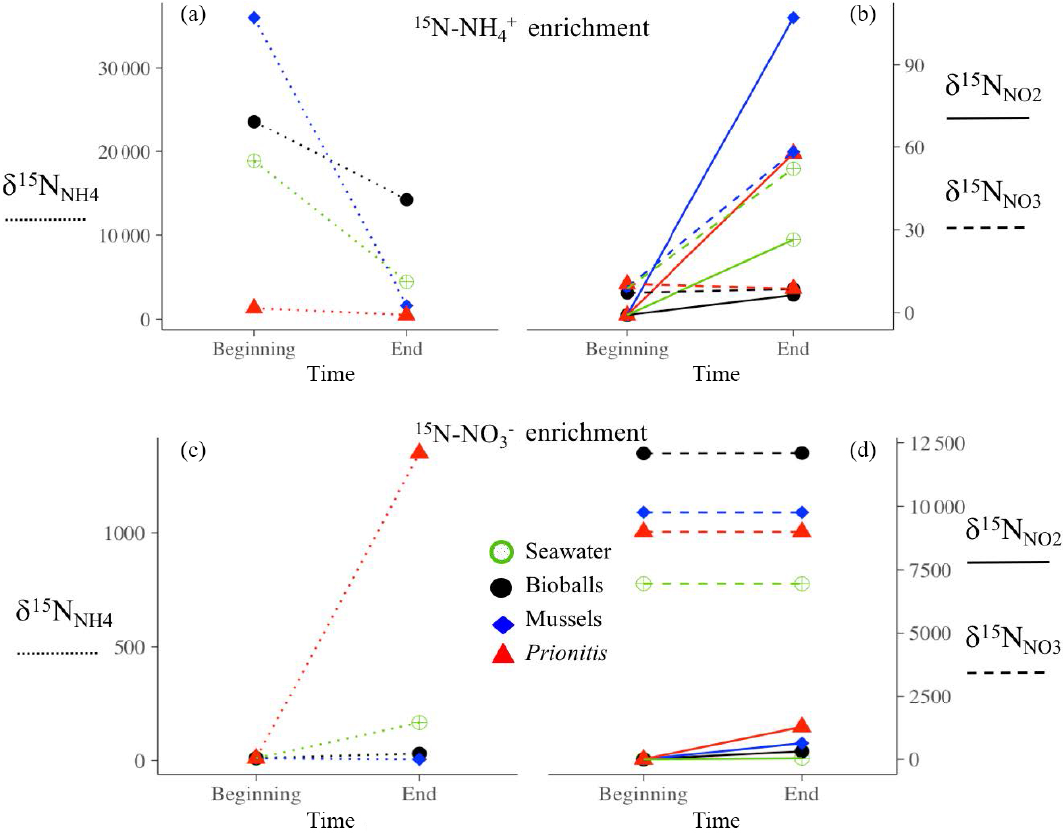
Figure A1. An example of each substrate type in an enrichment with 15 N-NH + enrichment in δ 15 N NO (solid line) and δ 15 N NO (dashed line) was measured (b) , while enrichment in δ 15 N NH 2 3 (d) followed the addition of 15 N-NO − . Ammonium regeneration in the chambers, particularly mussels, diluted the δ 15 N NH 3 Fig. 1f). Deviations in our target of initial enrichment (10000‰ and 2000‰) occurred due to natural variation in nutrient concentrations at the time of tracer